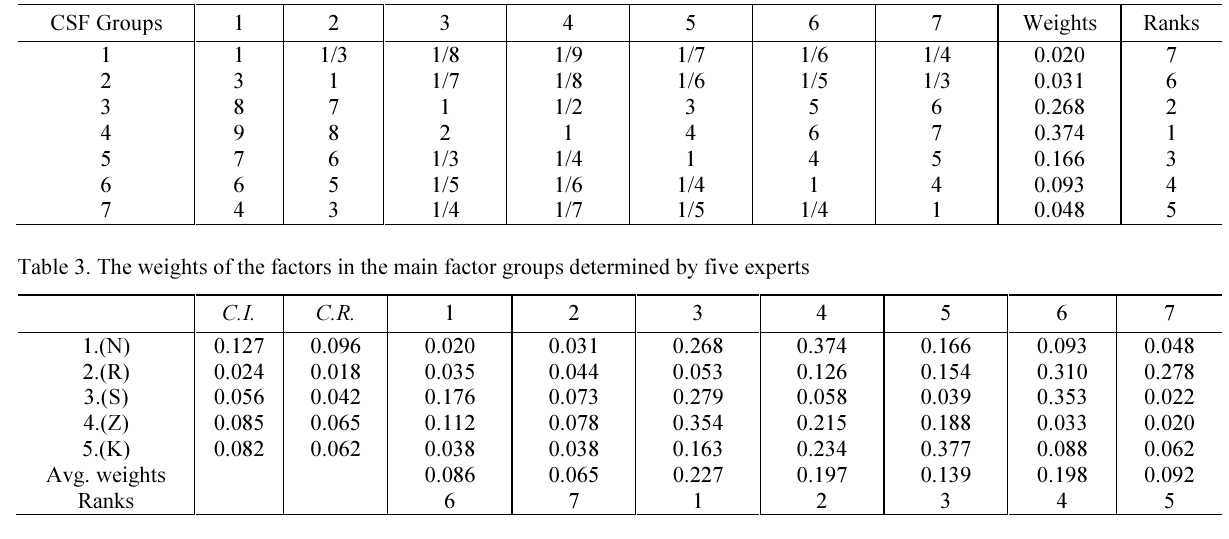
Table 4. CSFs ranking with local and global weights Level